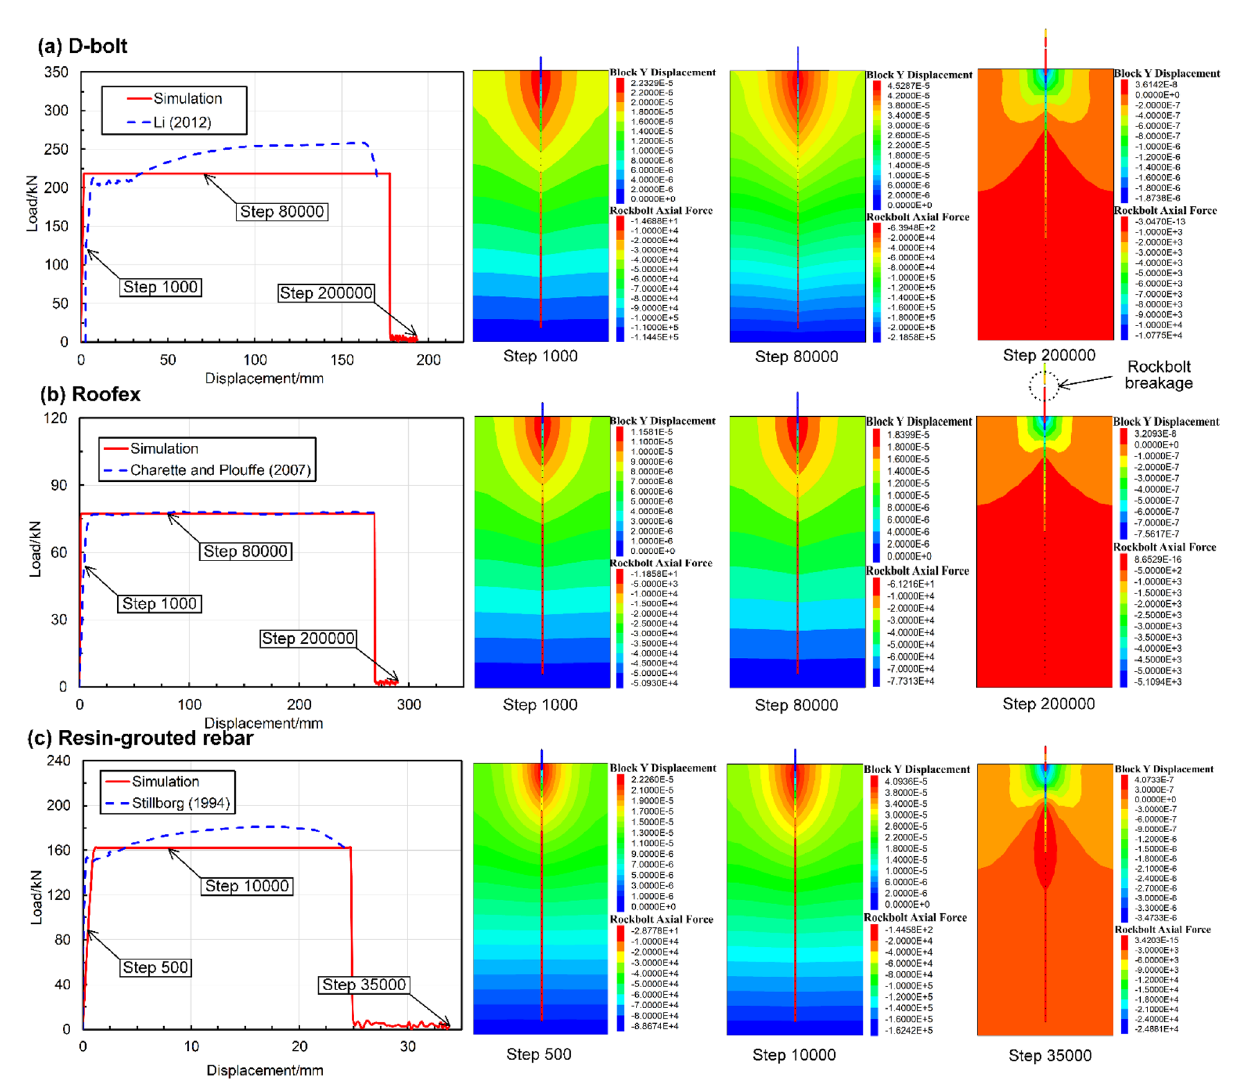
Fig. 11 Simulated load-displacement curves and axial forces of rockbolts and deformation of rock masses. (Rockbolt axial force in N and block Y displacement in Table 5 Calibrated input parameters of rockbolts Rockbolt type Cross- sectional